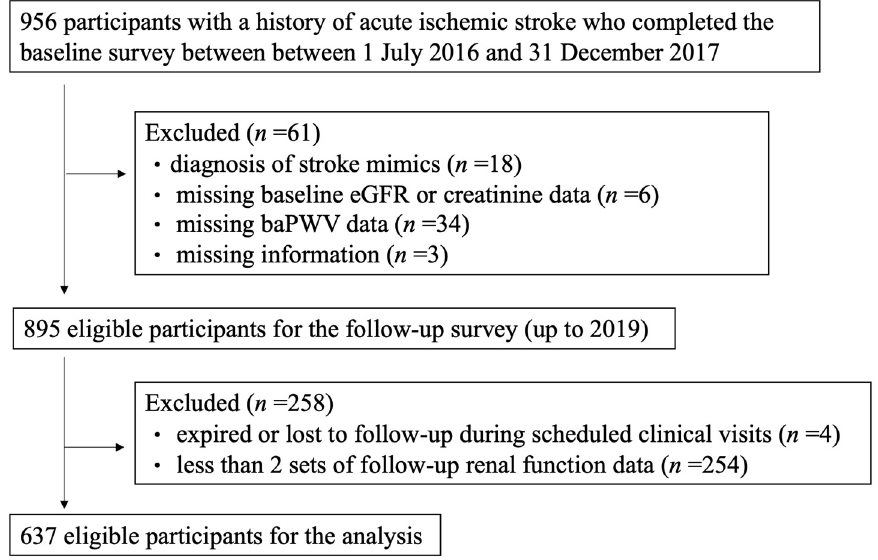
Figure 1. The flowchart of patient enrollment in this study. Table 1. Baseline characteristics and comorbidities of the enrolled subjects with acute ischemic stroke.